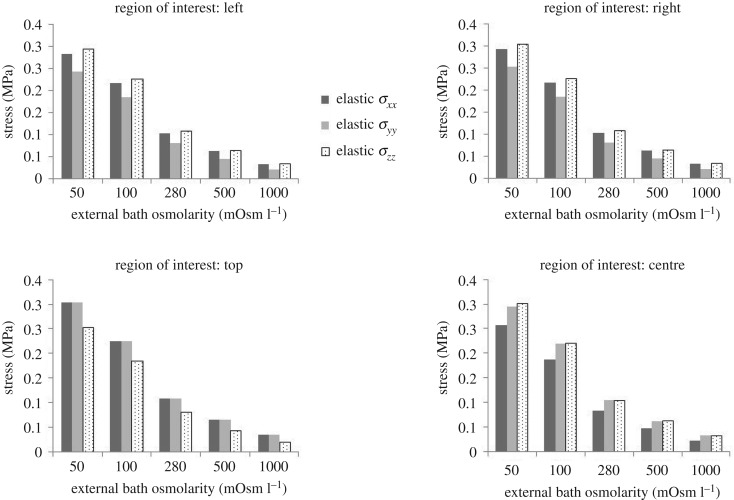
Maximum elastic stresses σxxe, σyye and σzze in four ROIs for external bath osmolarity at 50, 100, 280, 500 and 1000 mOsm l−1.